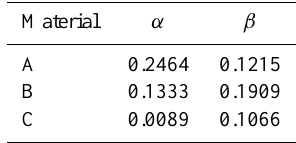
Table 4. Material